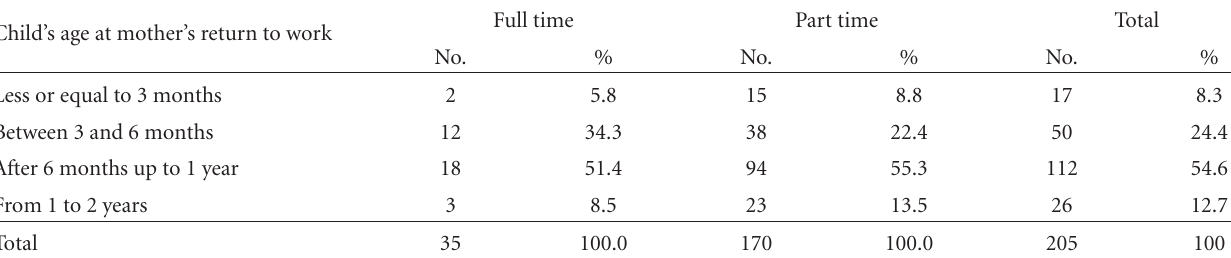
Table 2: Timing of mothers’ return to the workforce.